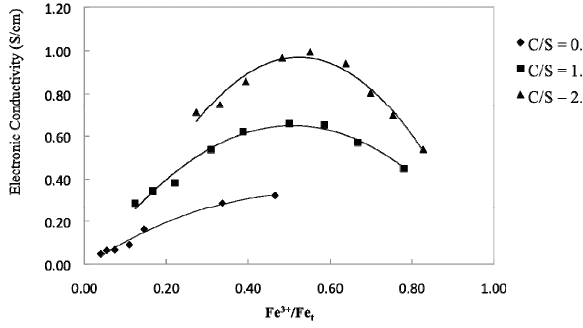
Figure 2. Variation of electronic conductivity at 1750K in the FeO-SiO 2 -CaO system (30 mass% FeO) C/S= CaO / SiO 2 (data as reported in